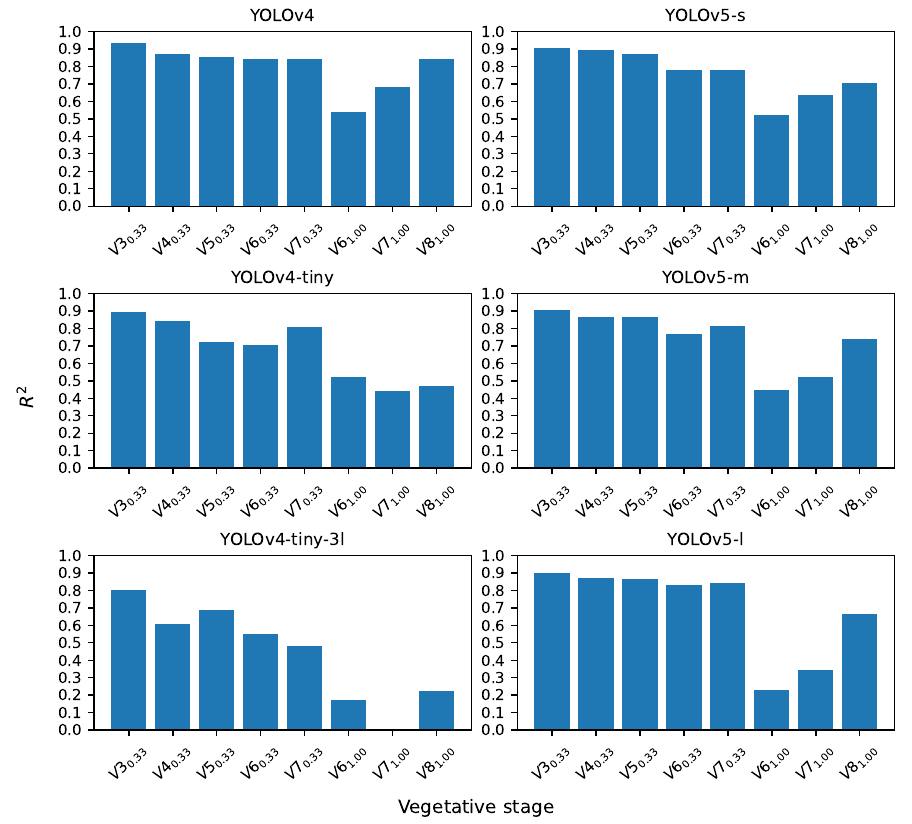
Figure 13. R 2 determined for each vegetative stage considering detections with a confidence level greater than 0.30 and IoU of